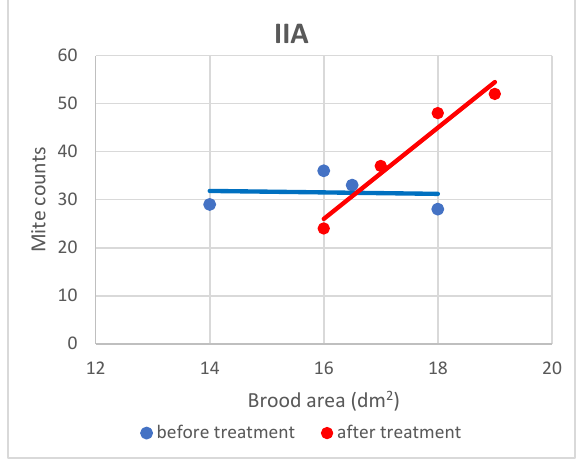
Figure 3. Linear regression plots of brood area (fixed factor) and mite counts in subgroups Ia before and after treatment.